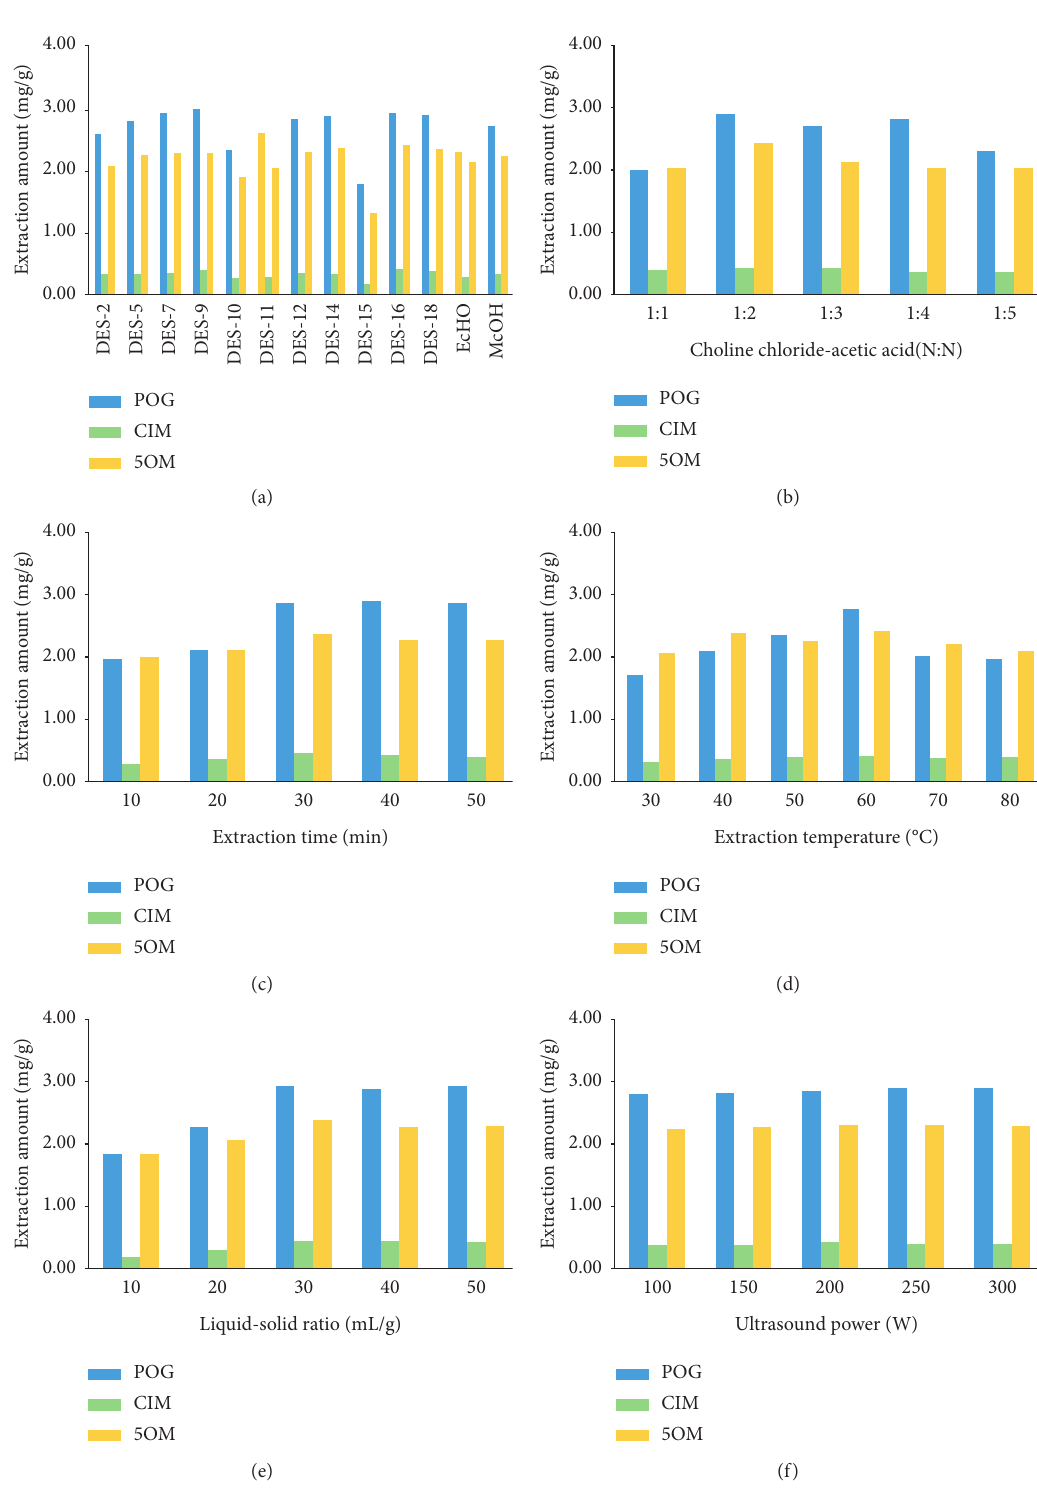
Figure 2: Effects of different types of DES (a), different ratios of DES (b), different extraction times (c), different extraction temperatures (d), different liquid/solid ratios (e), and different ultrasound powers (f) on the extraction rates of